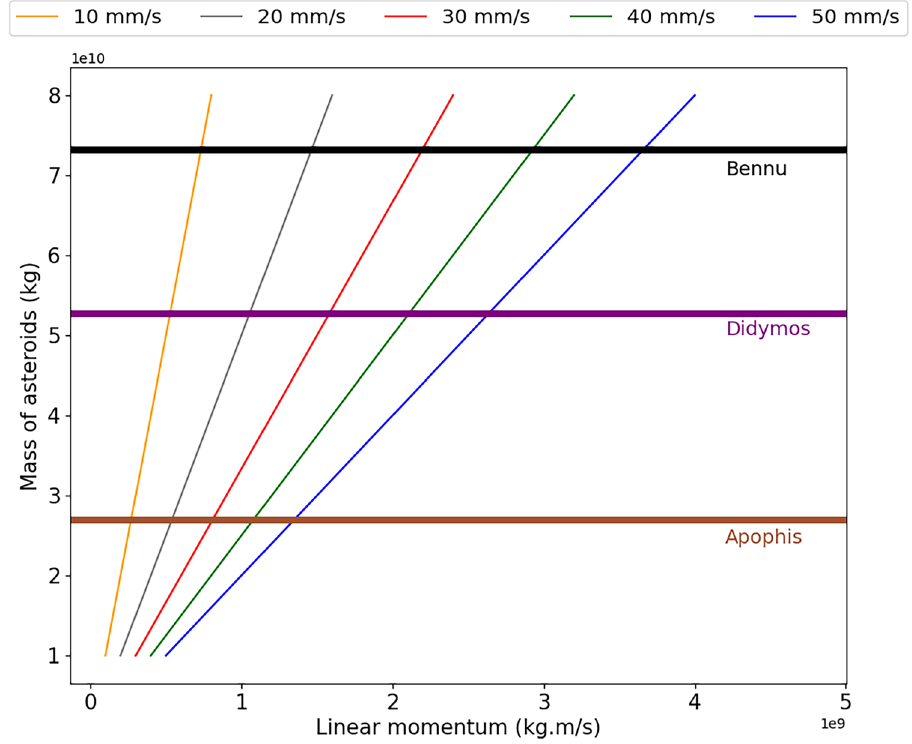
Figure 1. Relationship between the linear momentum required to make positive velocity variations in the asteroids as a function of the mass of the asteroids in a scale of 10 10 . The results for negative changes in velocity are symmetrically equal, having a negative momentum value. We are using the asteroids 99942 Apophis, 65803 Didymos and 101955 Bennu, the latter being the target of this work.